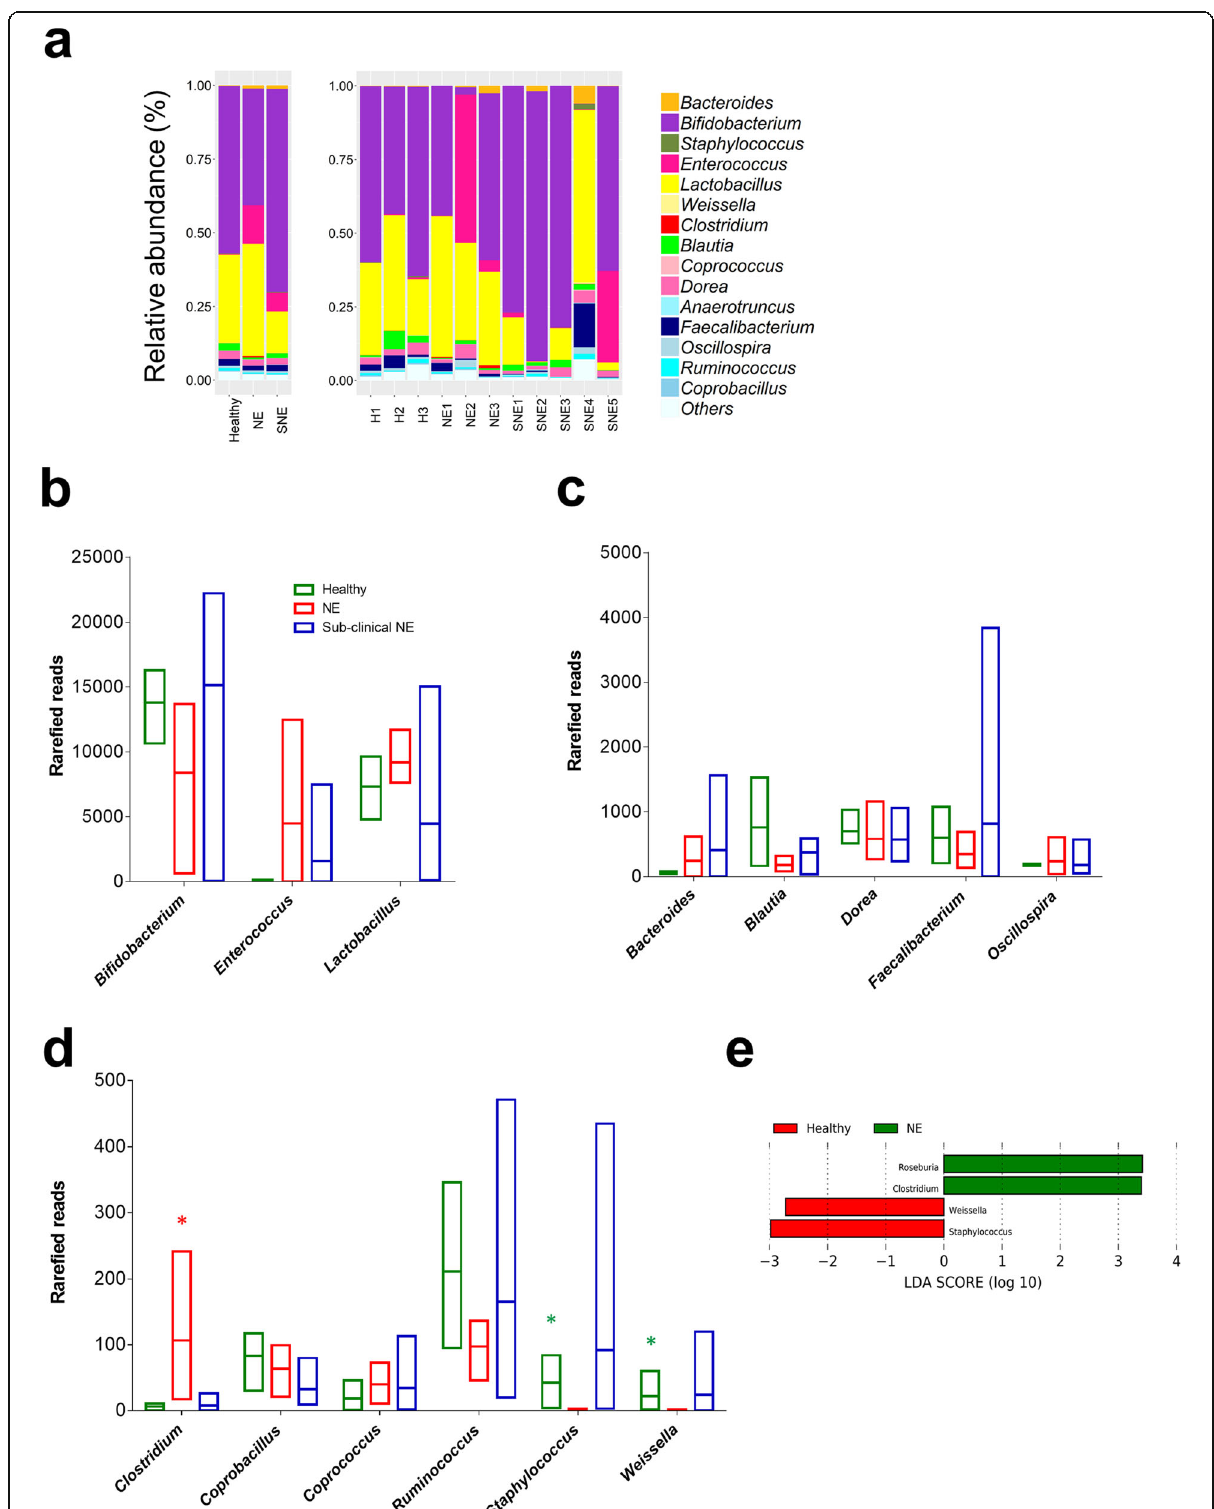
Fig. 5 a Relative abundance of Operational Taxonomical Units (OTUs) based on 16S rRNA amplicon sequencing in 11 individual caecal samples on genus level, with classified comparisons on healthy, NE and SNE (sub-clinical NE) samples. b-d Comparison of taxa reads in 3 groups of samples. e Linear Discriminant Analysis (LDA) indicating significantly enriched